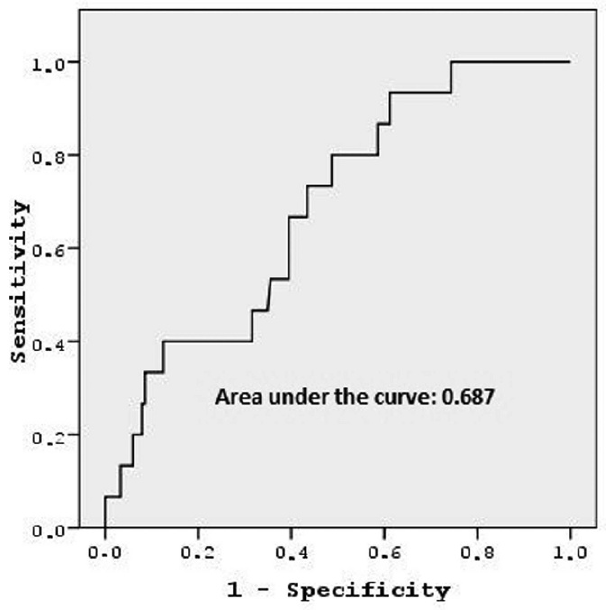
Figure 1 - ROC curve for NLR